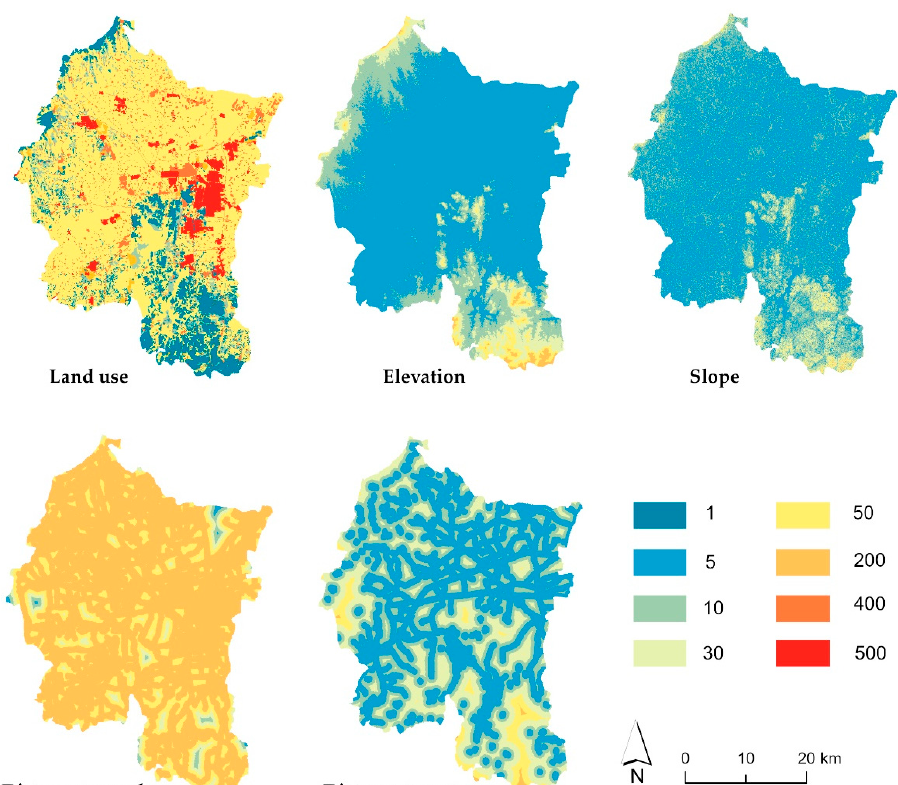
Figure 8. Single-factor resistance.